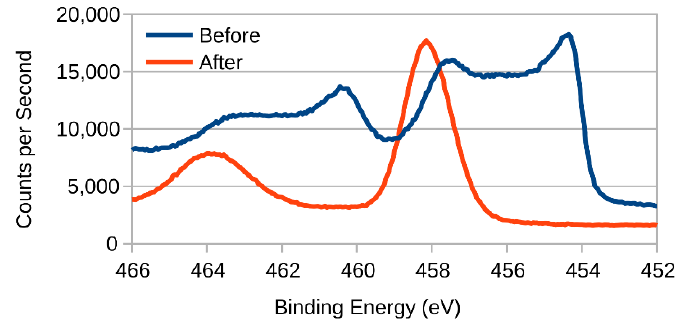
Figure 10. XPS results for the Ti 2p region before and after use as an anode.